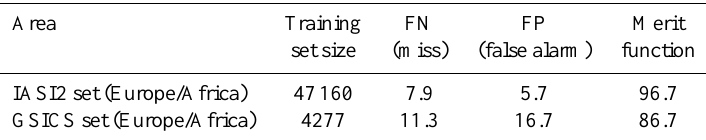
Table 8. Validation results based on the co-location of IASI/SEVIRI. The first row refers to the IASI2 data set and the second row to the GSICS data